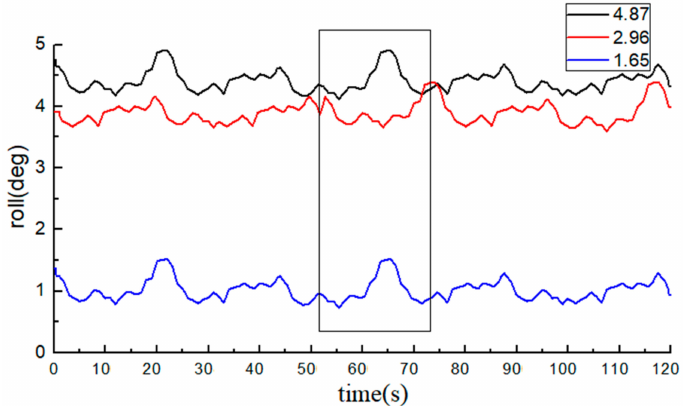
Figure 16. Dynamic data from the integrated system at di ff erent measuring angles (roll angle data are all